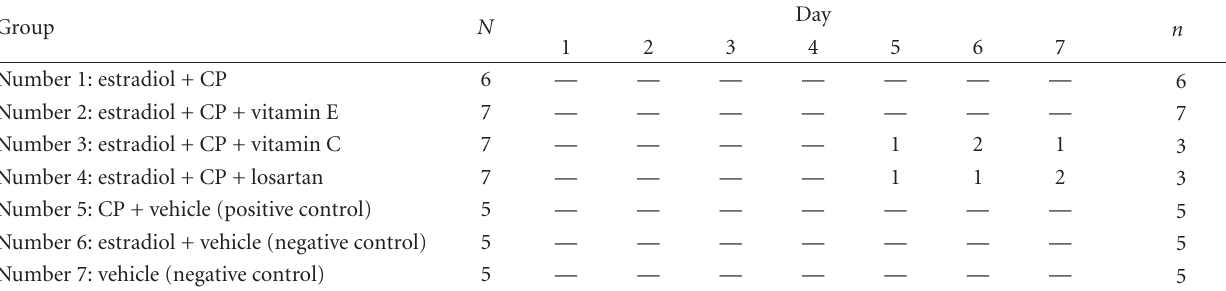
Table 2: The mortality rate of animals in each group during the second week of the experiment. Group N